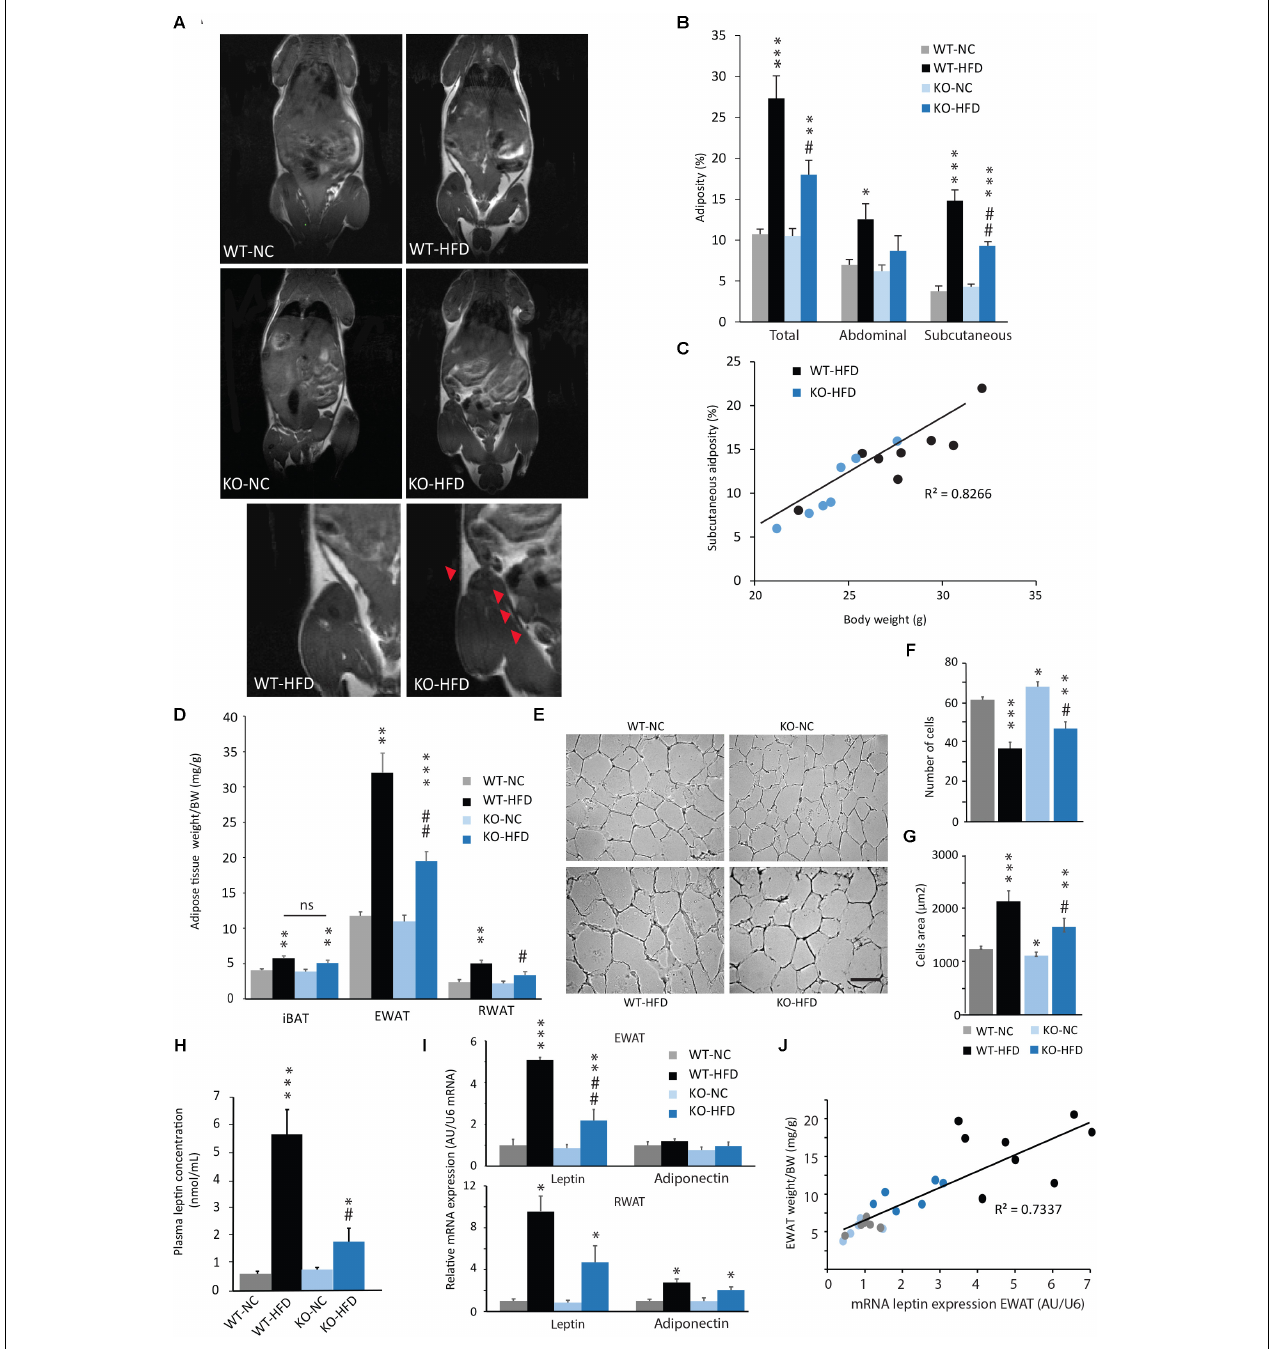
FIGURE 3 | Reduced adiposity in HFD-fed mPGES-1 KO mice. (A) Coronal MRI analysis of WT and KO mice fed with normal chow (NC) or a high-fat diet (HFD) for 14 weeks. Slice of representative mice are shown. Detail images focus on reduced subcutaneous adiposity (arrowheads) in HFD-fed mPGES-1 KO mice compared with HFD-fed WT mice. (B) Quantification of total, visceral and subcutaneous adiposities (%) of 14-week-fed WT and KO mice. (C) Correlation analysis was performed on the body weight and subcutaneous adiposity of HFD-fed WT and KO mice ( R 2 = 0.82). (D) Weights (g/BW) of interscapular brown adipose tissue (iBAT), epididymal white adipose tissue (EWAT) and retroperitoneal white adipose tissue (RWAT), in WT and KO mice fed either with NC or a HFD for 14 weeks. (E) Representative photomicrographs of EWAT histology in WT and KO mice fed either with NC or a HFD. Quantification of adipocytes number per surface unit (F) and adipocytes area ( G , µ m 2 ) in EWAT of WT and KO mice fed either with NC or HFD. (H) Dosage of plasmatic leptin (nmol/mL) in all experimental groups. (I) Real-time PCR analysis of leptin and adiponectin mRNA expression in EWAT and RWAT from WT and KO mice fed either with NC or HFD. (J) Correlation analysis was performed on the body weight and subcutaneous adiposity of WT and KO mice fed either with NC or a HFD ( R 2 = 0.73). Data shown are mean ± SEM. ∗ , significantly different from WT-NC; # , significant difference between WT-HFD and KO-HFD; ∗ p < 0.05; ∗∗ p < 0.01; ∗∗∗ p < 0.001; same statistical parameters apply to # symbol; and ns, not significant. Scale bar: 100 µ